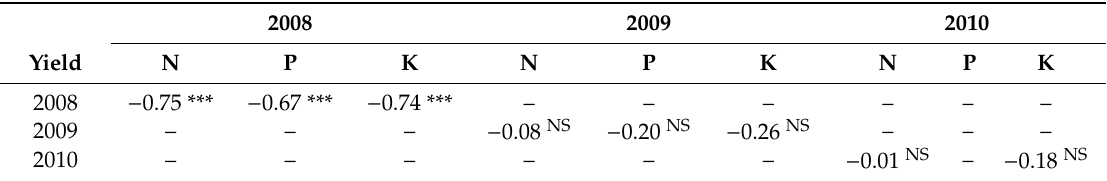
Table 3. Simple correlation (Pearson) between yields and macronutrients concentration in the aboveground portions (AG) of switchgrass. Results were obtained with all replicate